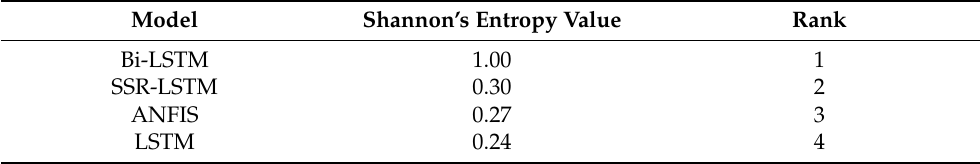
Table 10. Shannon’s entropy-based model ranking for one-day-ahead ET 0